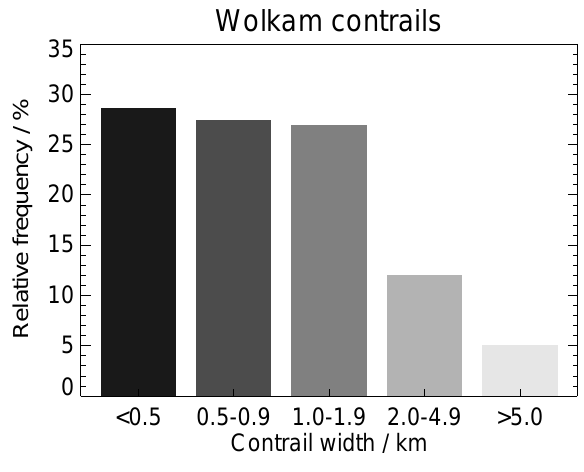
Fig. 6. Width distribution of 175 contrails observed using the all- sky